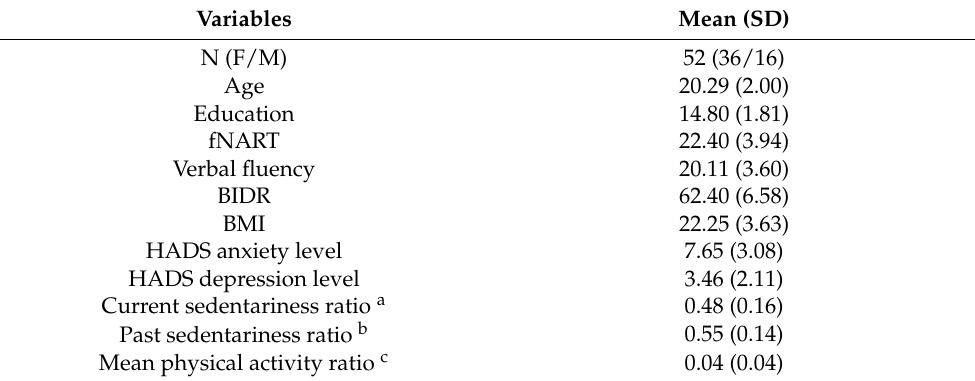
Figure 1. Flow chart of study participants. Table 1. Description of the demographic characteristics (mean and standard deviation in brackets), current and past sedentariness ratios, and average physical activity ratio of the final sample.